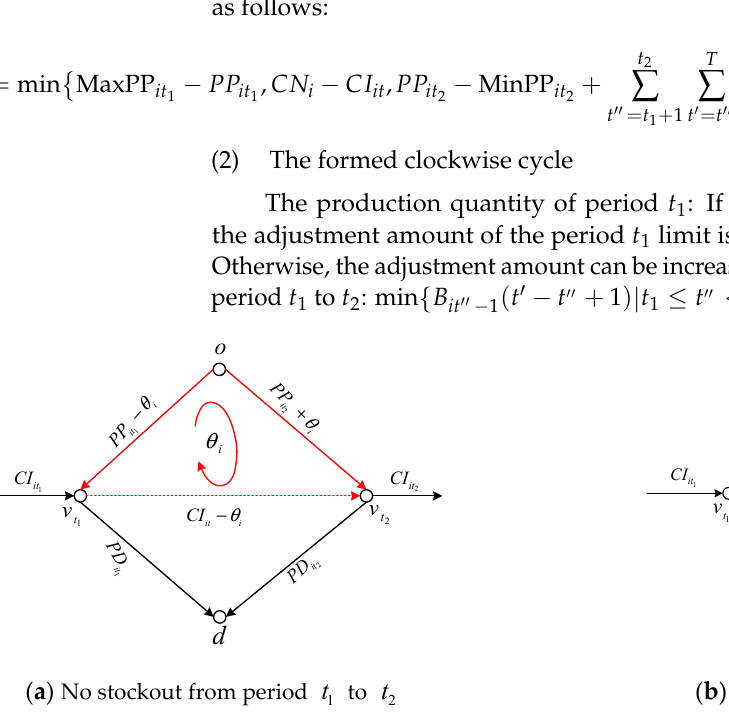
Figure 3. Illustration of augmenting flow in anticlockwise cycle.